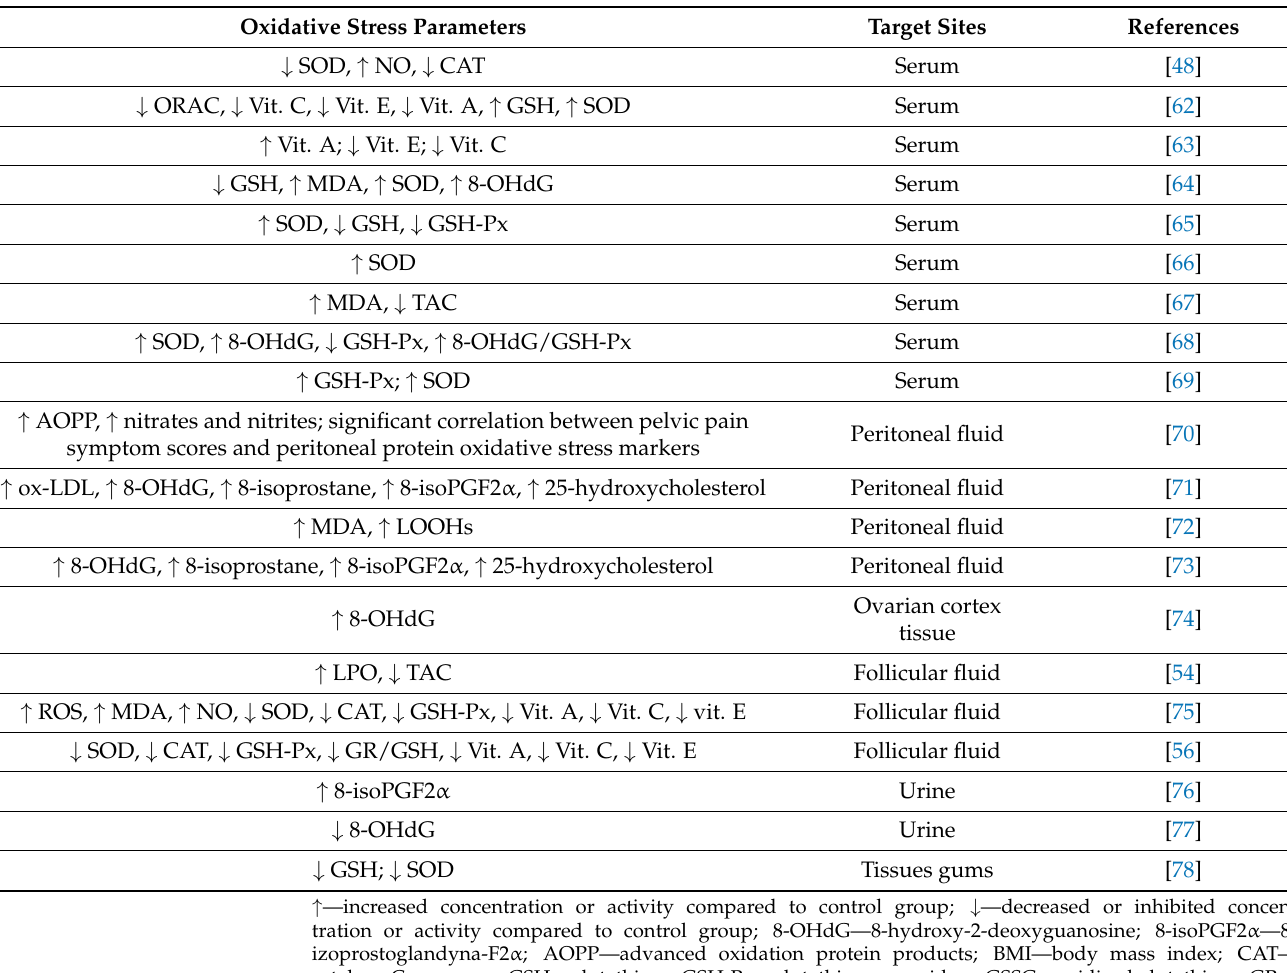
Table 1. Cont. Oxidative Stress